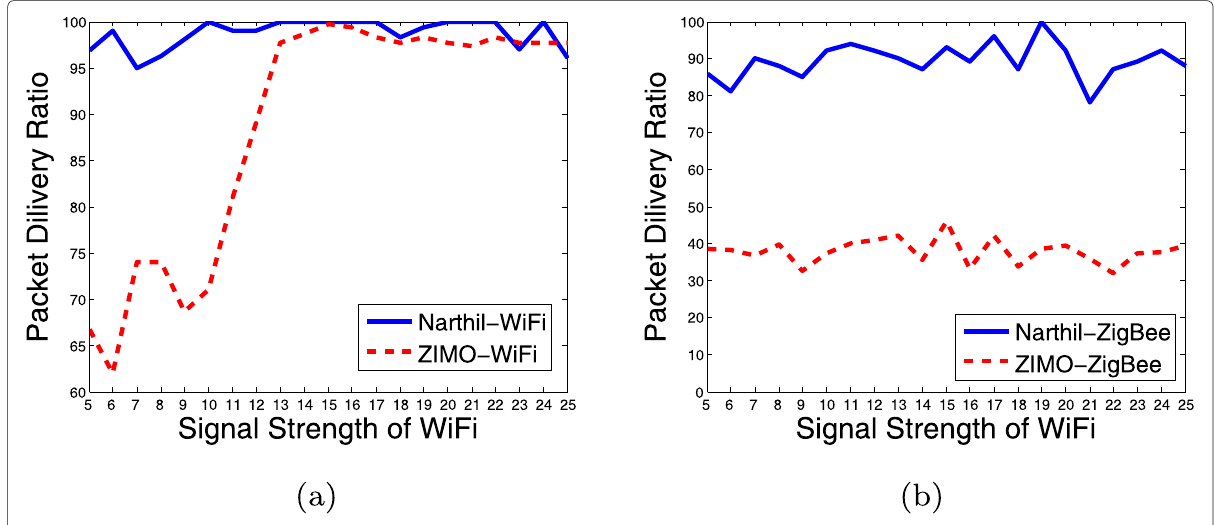
Fig. 21 System performance in typical interference scenarios. a WiFi decoding performance. b ZigBee decoding